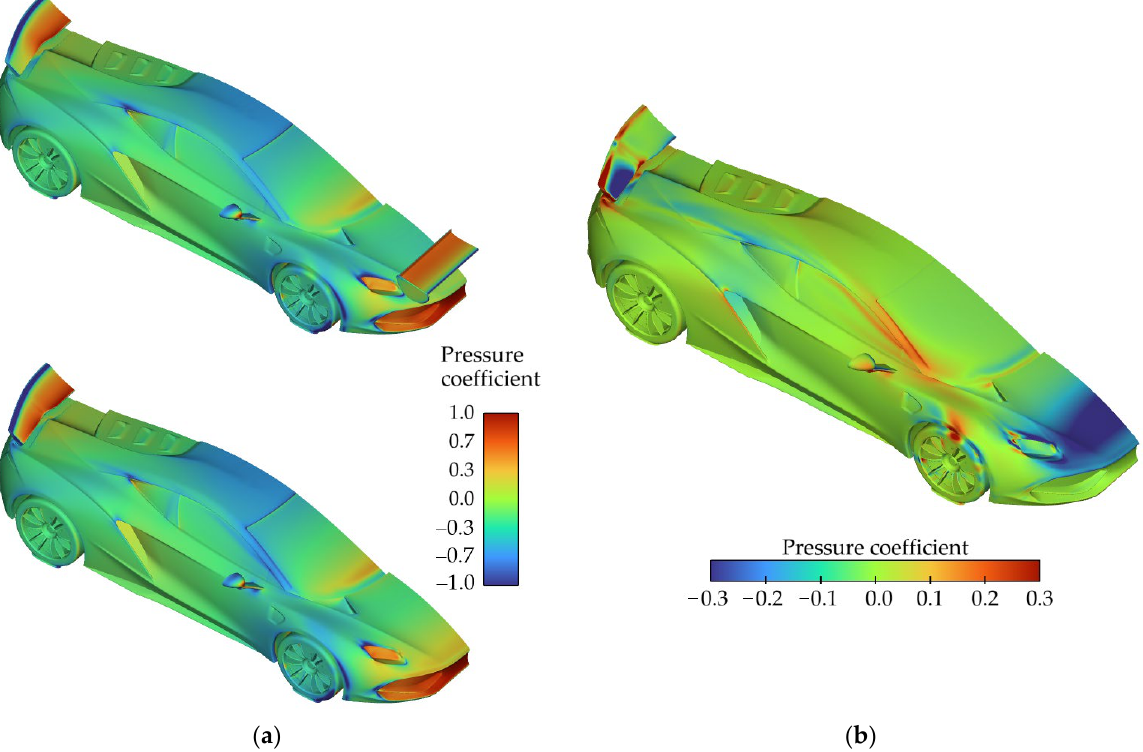
Figure 16. Pressure coefficient contour map: ( a ) without ( top ) and with ( bottom ) the front wing; ( b ) difference between cases with and without the front wing.